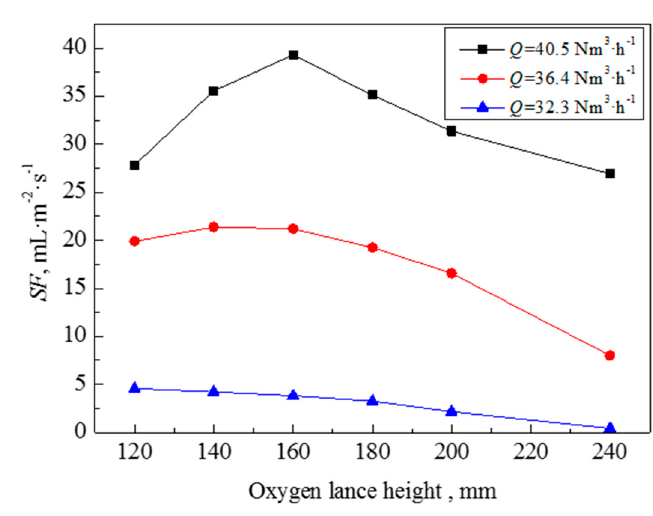
Figure 7. SF inside the furnace mouth under the different top-blown gas jet conditions.